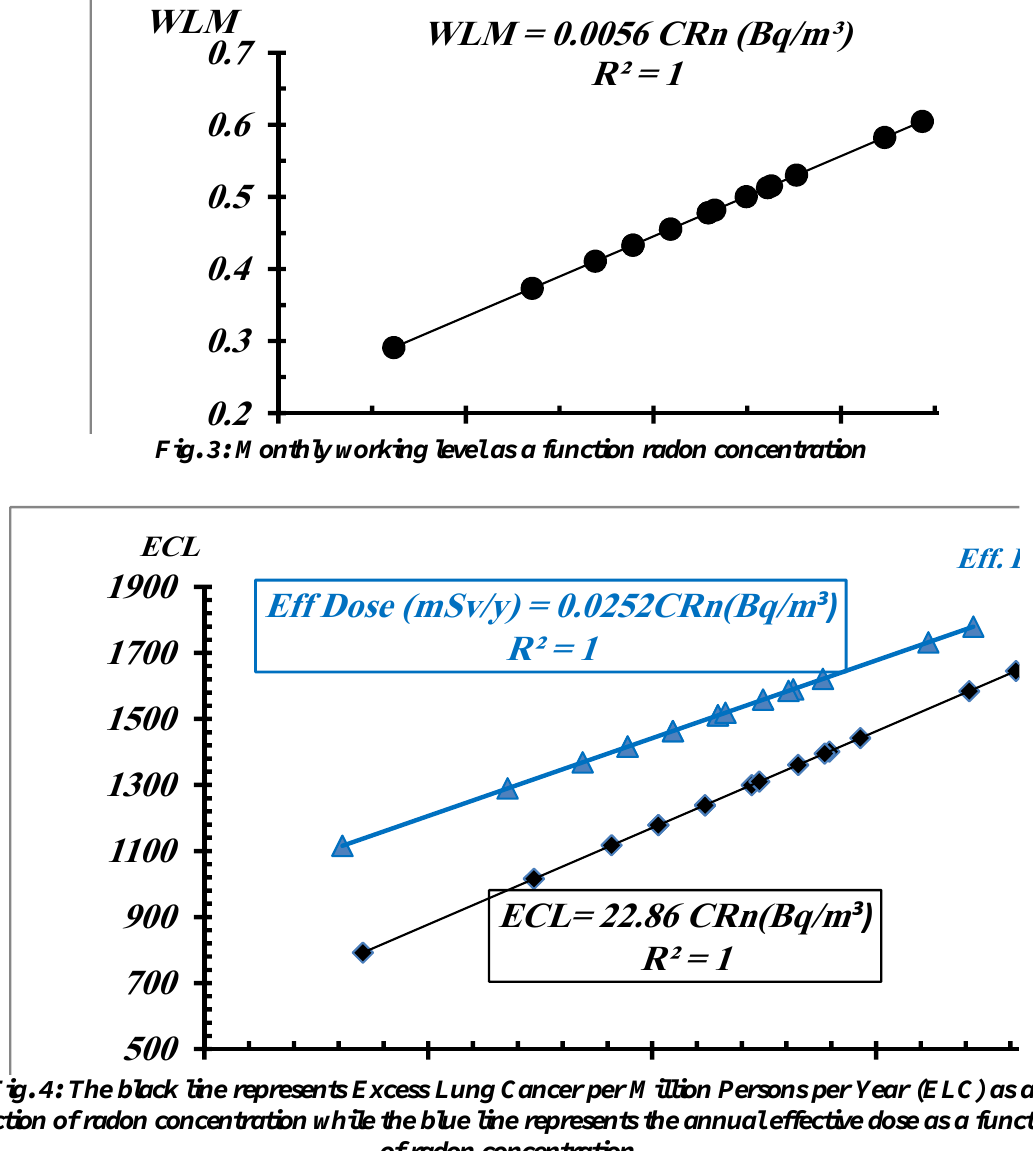
Fig. 4: The black line represents Excess Lung Cancer per Million Persons per Year (ELC) as a function of radon concentration while the blue line represents the annual effective dose as a function of radon